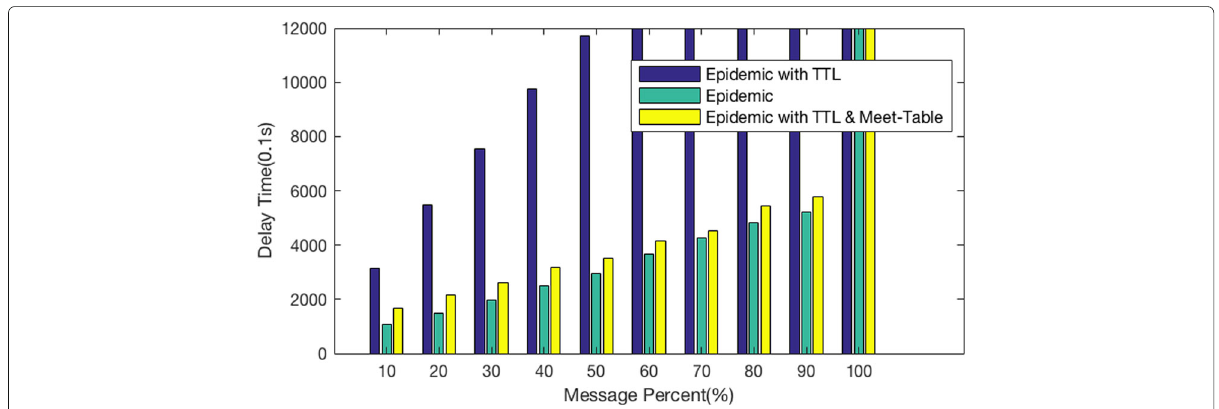
Fig. 6 Message percent vs. time delay